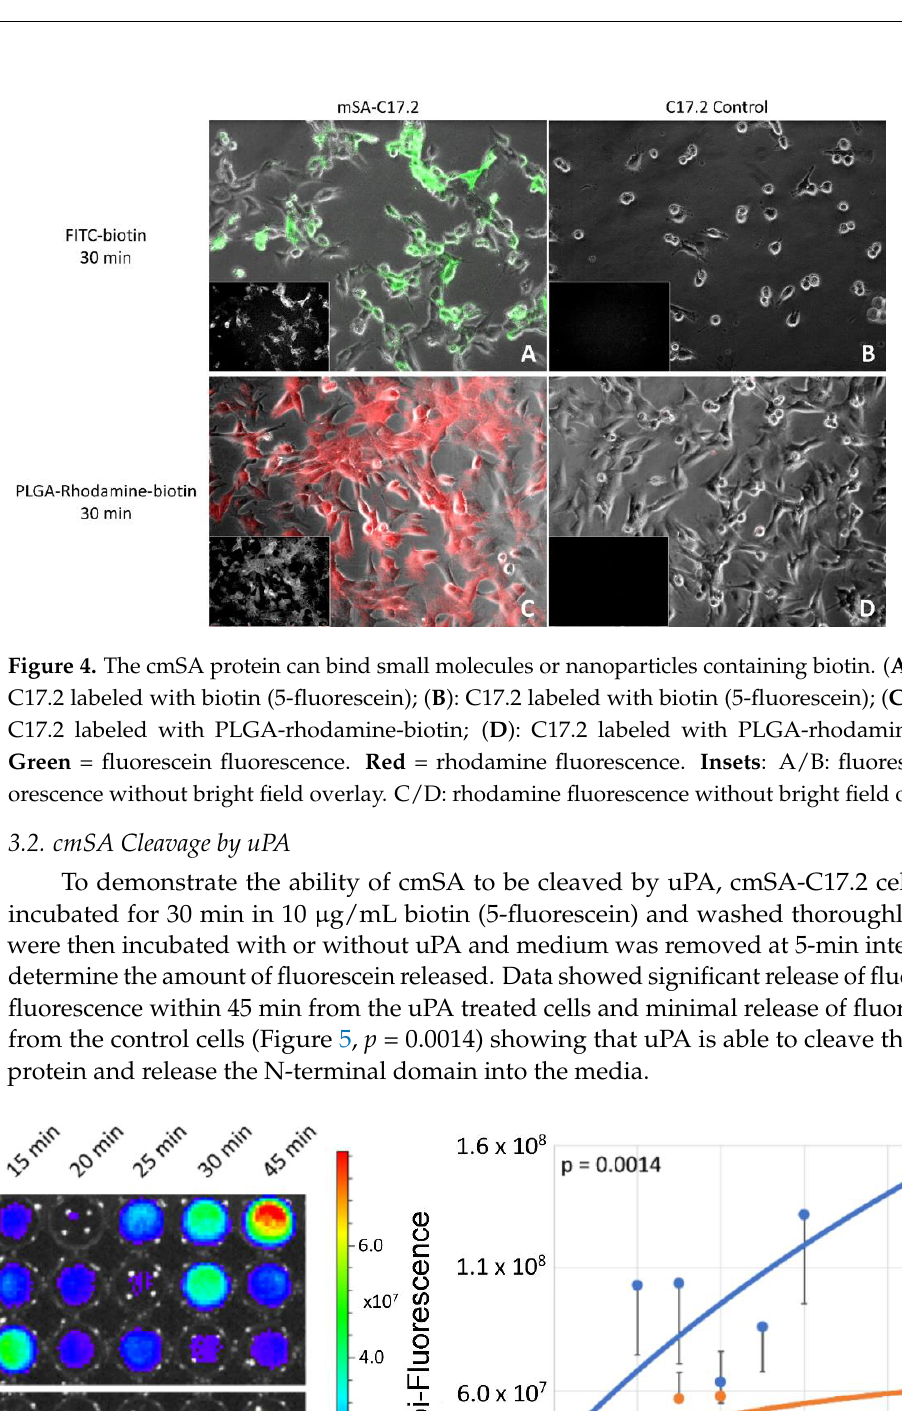
Figure 5. Urokinase can cleave the cmSA protein. ( A ) : IVIS™ images of media harvested from biotin (5-fluorescein) labeled cmSA-C17.2 incubated with or without uPA. ( B ) : Numerical data from panel A with best fit curves to demonstrate the trends. The repeated measures statistical test demonstrated the difference between uPA and no uPA was highly significant ( p = 0.0014).